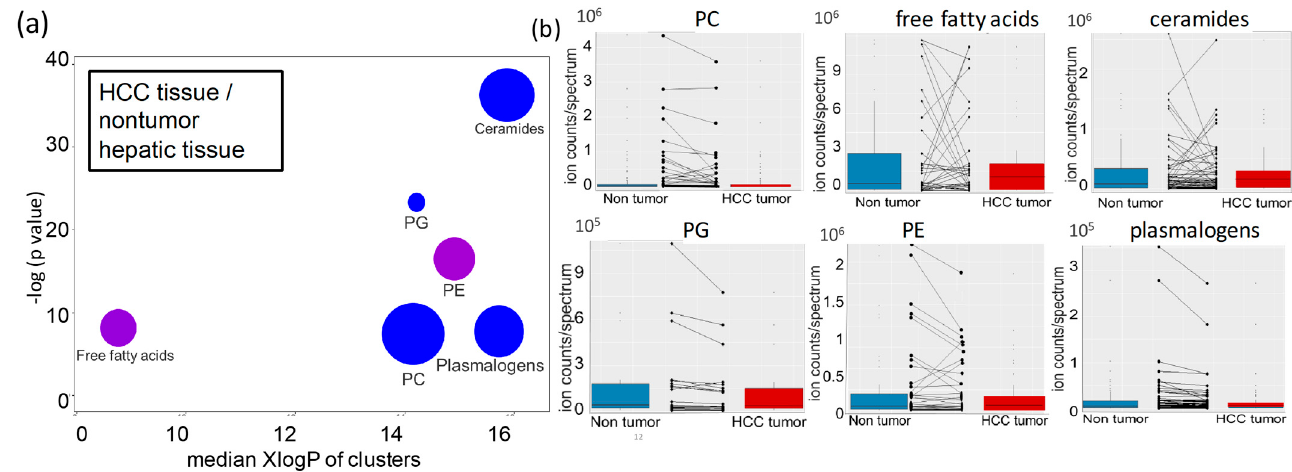
Figure 5. Lipid set enrichment statistics in HCC hepatic tissues versus nontumor hepatic tissues ( a ) ChemRICH plot. Bubble colors range from blue (decreased) to purple, indicating increased and decreased lipid species in lipid classes. Bubble size represents the number of compounds per lipid class. Lipid classes are ordered by median lipophilicity (XlogP) along the x-axis. ( b ) Boxplots of paired comparisons of significant lipid classes in HCC tumors versus nontumor hepatic tissues, including directions of change for individual lipid species in these classes. Abbreviations as in Figure 1.